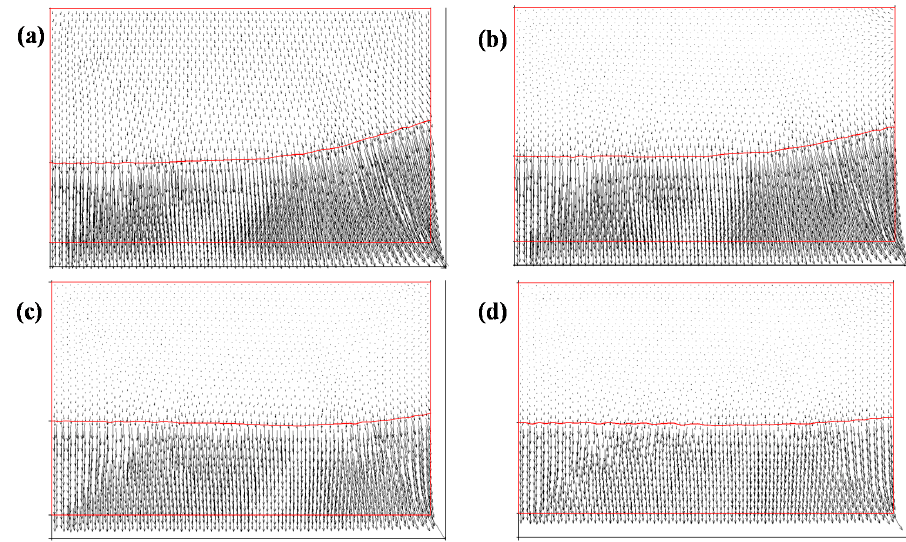
Figure 4. Heat flux distributions in solids for different power ratios: ( a ) 1:1, ( b ) 1:2, ( c ) 1:3, and ( d ) 1:4.